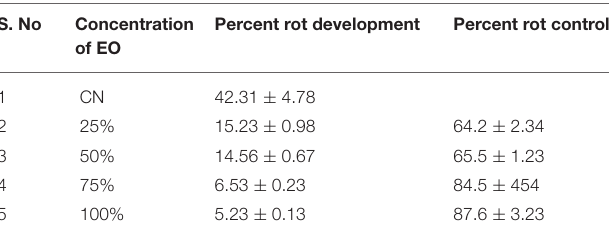
TABLE 3 | Effect of EO of Zanthoxylum armatum DC applied at different concentrations (25, 50, 75, and 100%) on the percent rot development and percent rot control in tomato fruits inoculated with spores of Alternaria alternata (Fr.) Keissl. S.